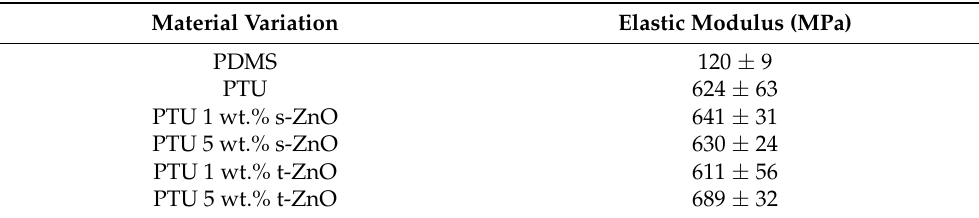
Table 2. Elastic modulus from tensile tests for PTU and PTU/ZnO variations.